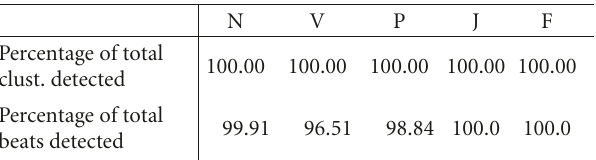
Figure 6: Raw tracing of ECG for patient 115 in the MIT-BIH database with normal beats: a sequence of ECG is shown con- taining normal beats. This sequence represents an example where morphology-based analysis separates the beats into short (first 7 beats) and long (last three beats) classes. The beats still fall in the same clinical class, but this separation, which indicates an abrupt change in heart rate, may potentially be of interest for the purpose of higher level analysis. This excerpt corresponds to time 7 : 40 in the recording.